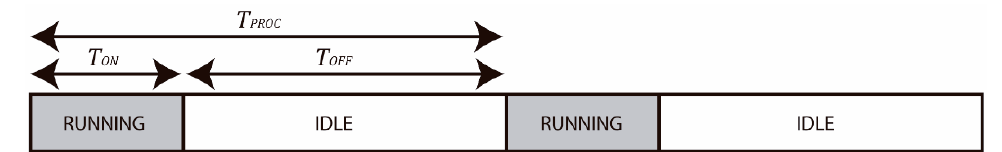
Figure 3. Execution scheme of the reference task.